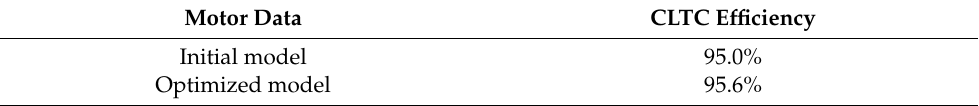
Table 7. Comparison of CLTC efficiency.